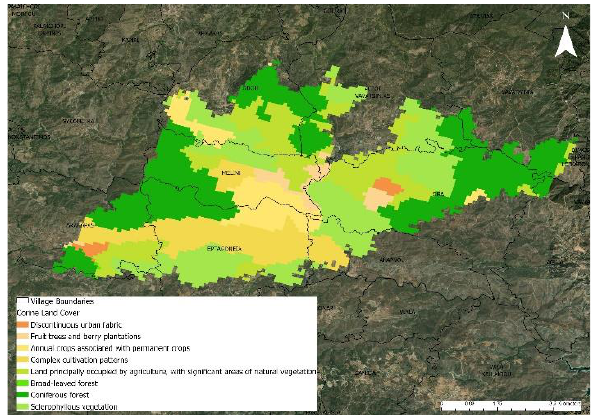
Figure 7 Vegetation type based on Corine land Cover data (2018)